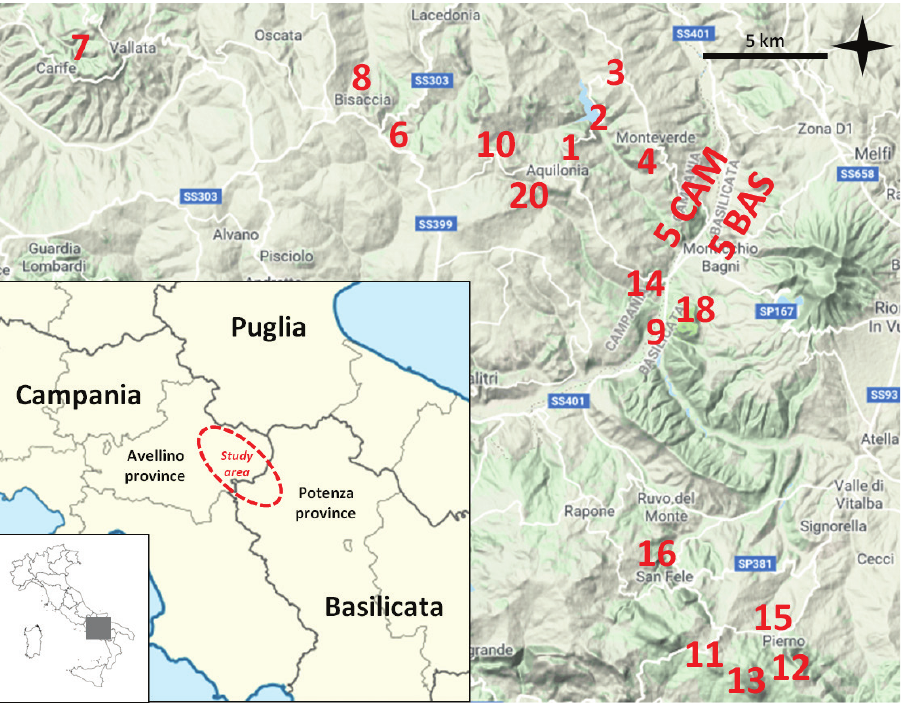
Figure 1. Location of study area and sampling sites (for details, see Suppl. materials 1: S2 and